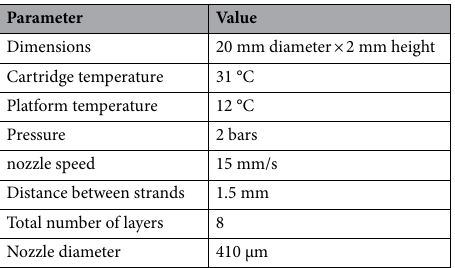
To treat the surface of the Film that faced toward the cells, the prepared membrane was allowed to float on 10% w/v NaOH overnight. The Film was finally rinsed with copious amounts of water to remove residual NaOH.